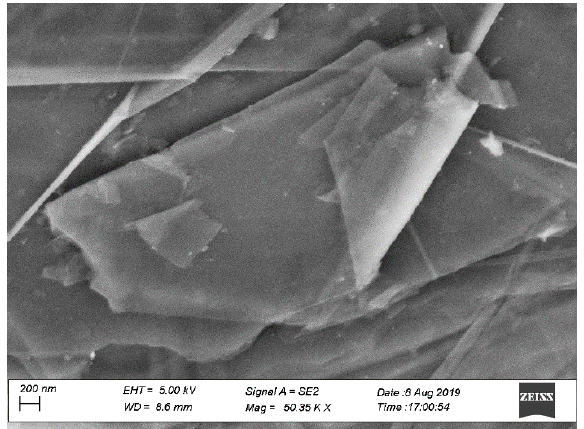
Figure 2. Scanning electron microscope of graphene nano-platelet (GnP) powder.